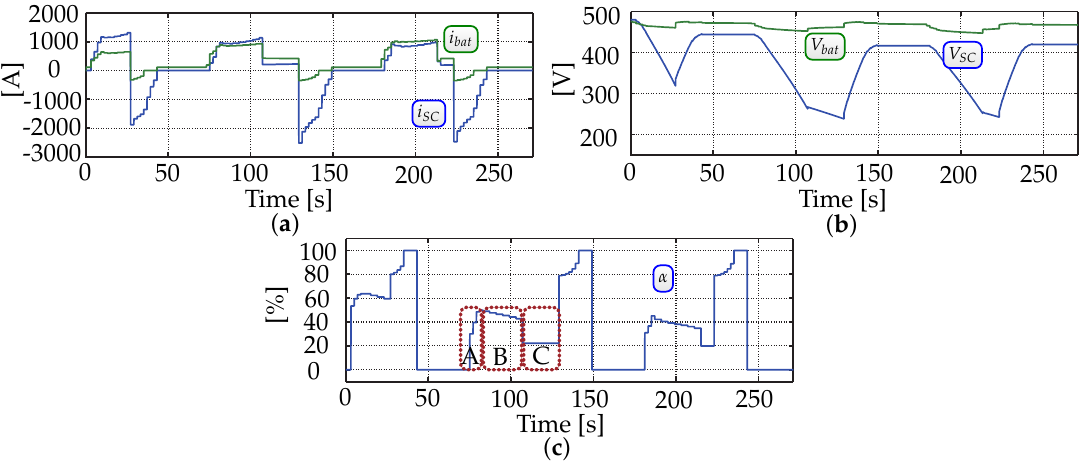
Figure 9. Simulation results for variable predictive horizon optimization EMS with three typical stops in the driving cycle of the LR: ( a ) battery current and SC current and ( b ) battery voltage and SC voltage and ( c ) power mix α